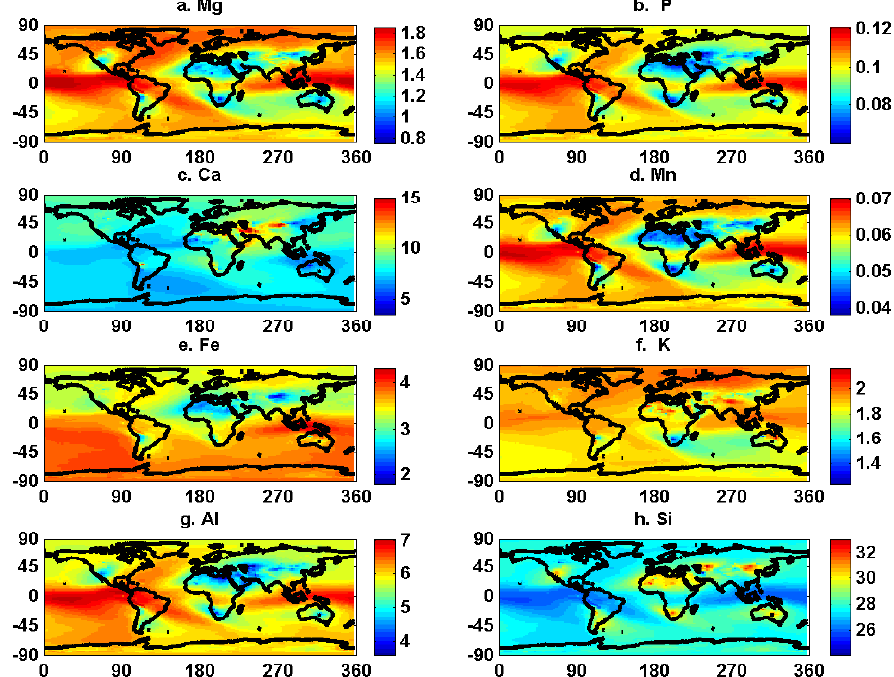
Figure 13. Percentages of elements in dust deposition (%) after tuning. It is tuned based on original percentages of elements in dust deposition in Fig. S1 by timing the observed/modeled ratios listed in Table 3. Si did not change because there are not enough observational data available.